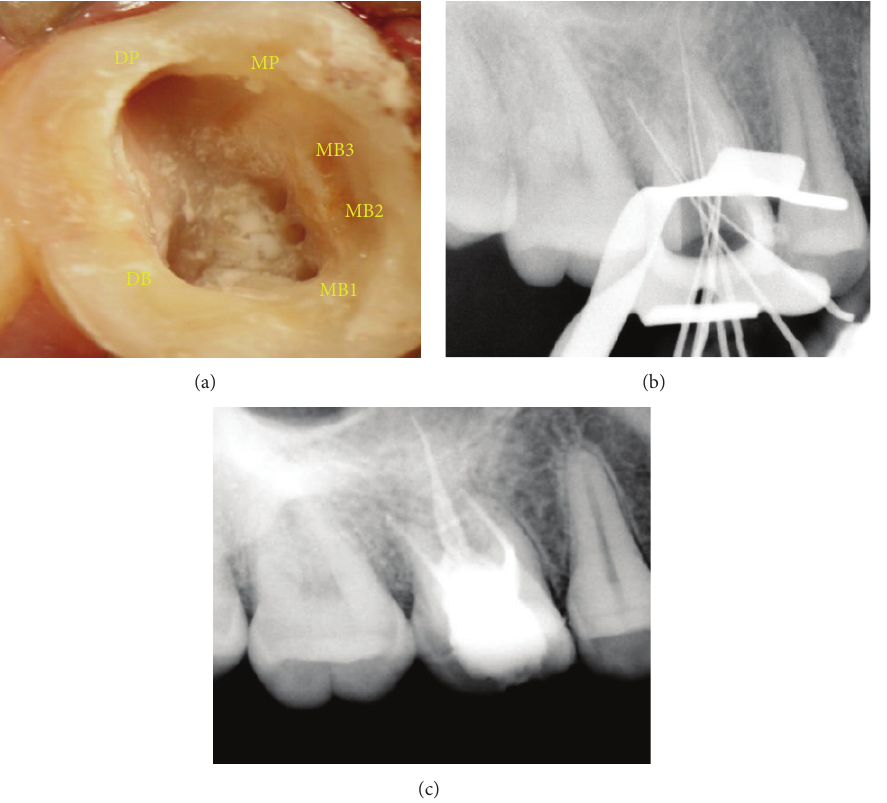
Figure 3: (a) Access opening showing three MB, two palatal, and one oblong distobuccal canal orifices. (b) Working length radiograph. (c) Postobturation